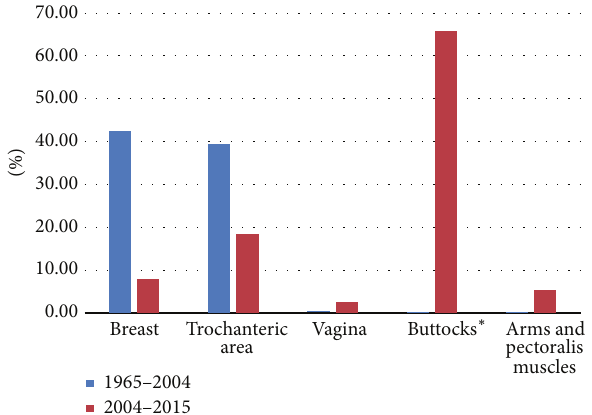
Figure 5: Difference in site of injections between two time periods (1965–2004 versus